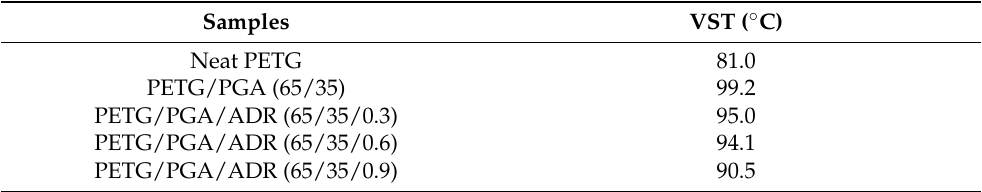
Table 6. VSTs of neat PETG and PETG/PGA/ADR (65/35/x)